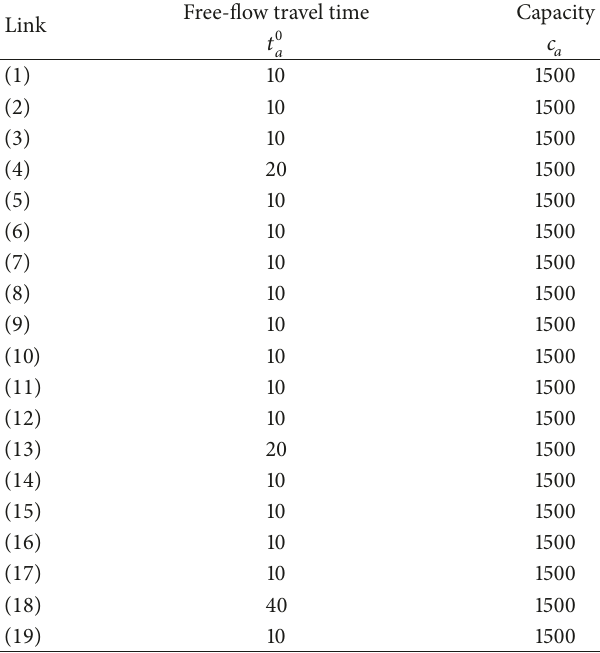
Table 1: Paths and link sequences. Table 2: Link travel time